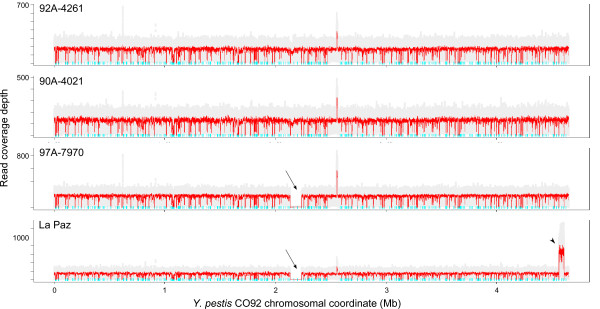
Coverage plots of Y. pestis chromosomes. Reads were mapped to the Y. pestis CO92 chromosome using mapreads. Each row represents a Y. pestis chromosome (strain indicated in the upper left of each plot) as described in Figure 1. The arrow in the 97A-7970 and La Paz plots indicates the deletion region depicted in detail in Figure 7. The arrowhead in the La Paz plot indicates the amplified region depicted in Figure 8.